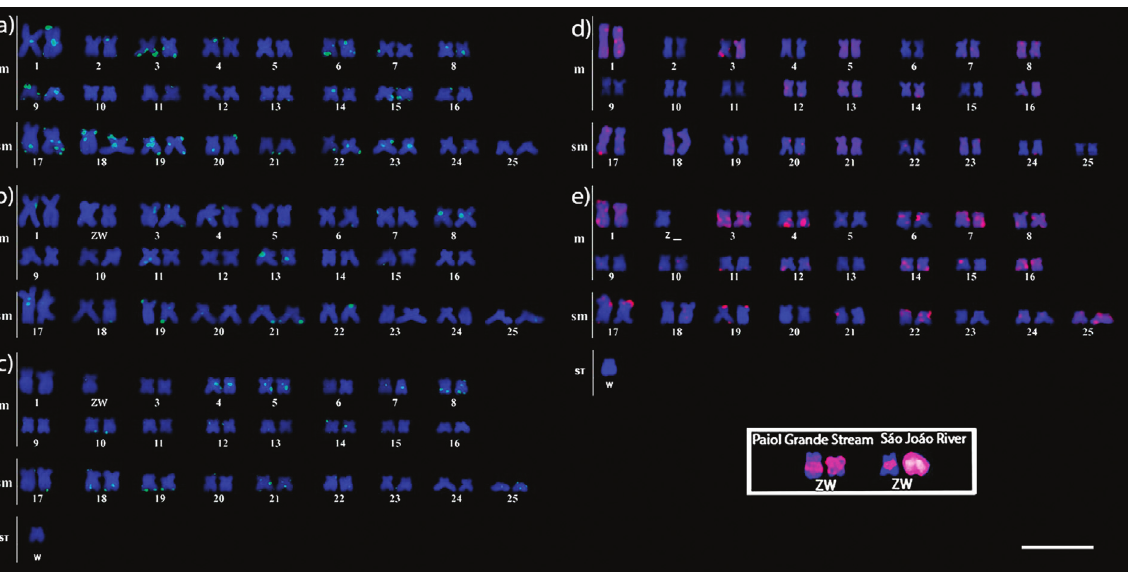
Figure 2 - Karyotypes of Characidium females subjected to fluorescence in situ hybridization (FISH) with TE probes. (a) C. zebra , (b) C. gomesi (PG), (c) C. gomesi (SJ); (d) C. zebra , (e) C. gomesi (SJ). The Rex3 probe did not show any hybridization signals in C. gomesi (PG) chromosomes (not shown). The W and Z sex chromosomes of C. gomesi females are highlighted in the box. PG, Paiol Grande Stream population; SJ, São João River population. Scale bar, 10 (cid:2)